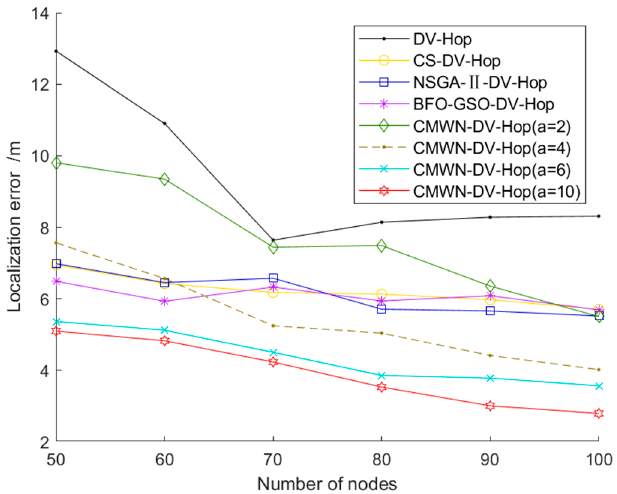
Figure 9. Comparison of various localization algorithms with different numbers of nodes: localization error.